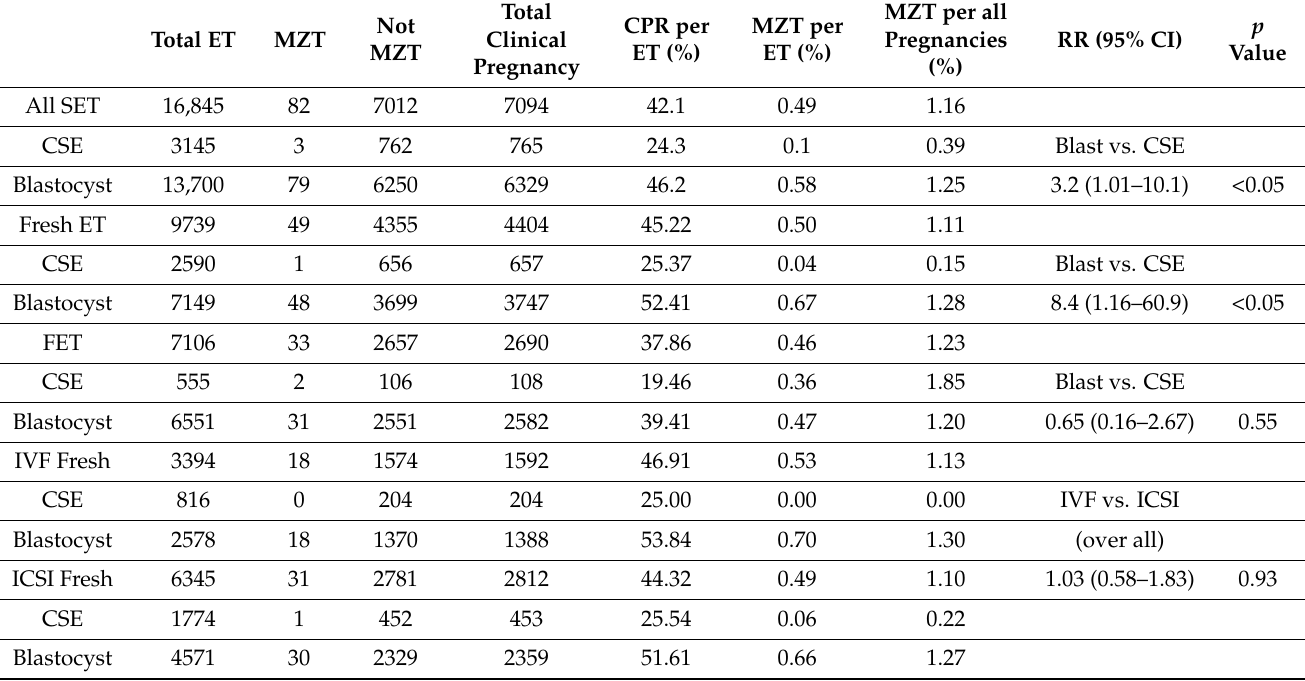
Table 1. SET cycles and MZT